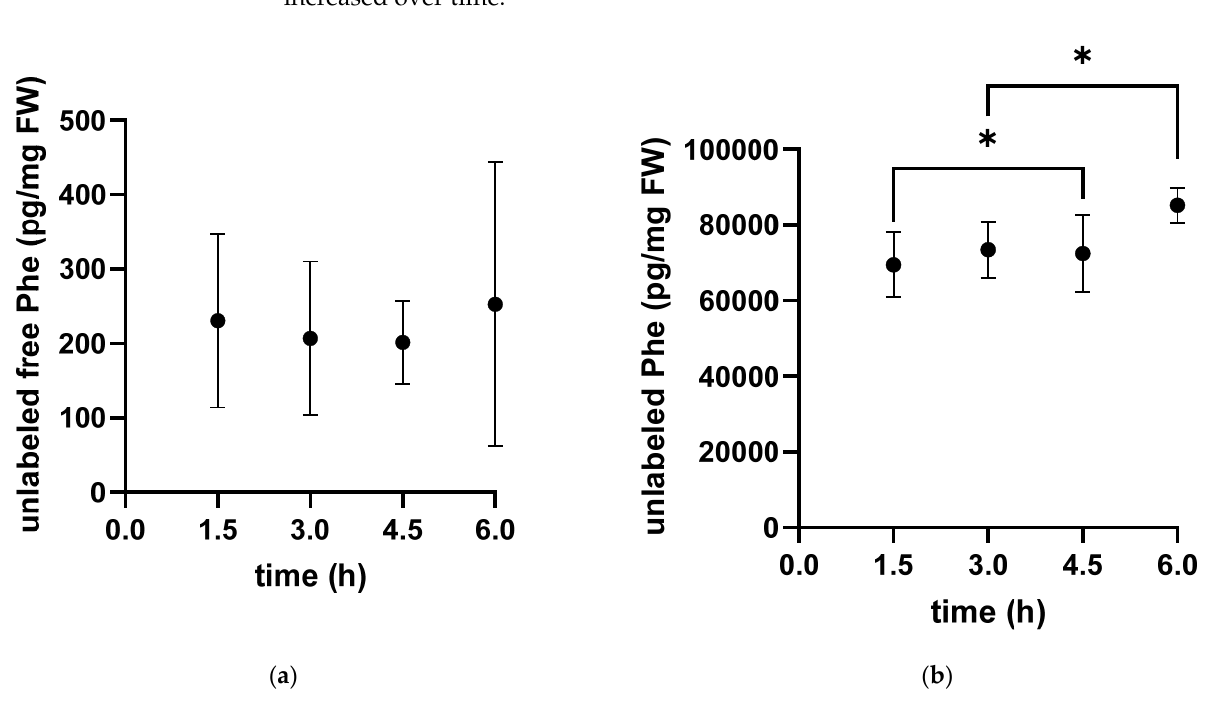
Figure 2. Time-dependent concentration of unlabeled phenylalanine in the free pool ( a ) and protein-bound unlabeled phenylalanine ( b ) in white muscle tissue extracts of the Antarctic eelpout Pachycara brachycephalum kept at 0 °C. The unlabeled free pool ( a ) decreased within the first 3 h and reached a plateau thereafter. The unlabeled bound fraction ( b ) increased over time (* p < 0.05). The data between 1.5 and 4.5 h meet all criteria required to calculate Ks after injection